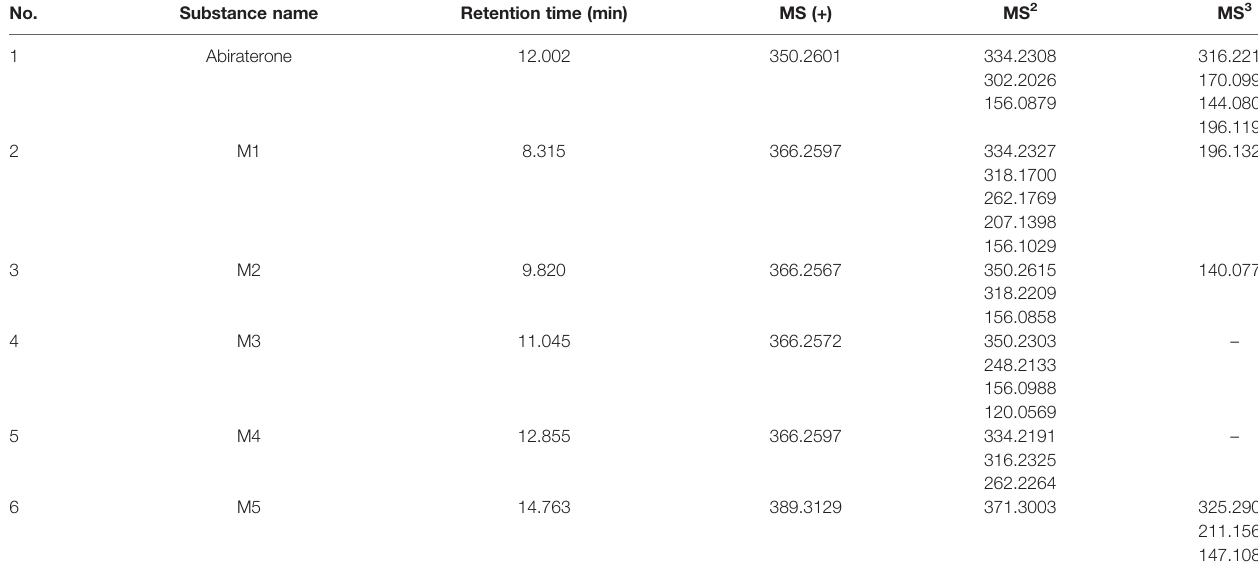
TABLE 2 | The multistage mass spectrometry information of Abiraterone and its metabolites from the intestinal micro fl ora metabolic system and liver microparticle incubation system by LC/MS n -IT-TOF.